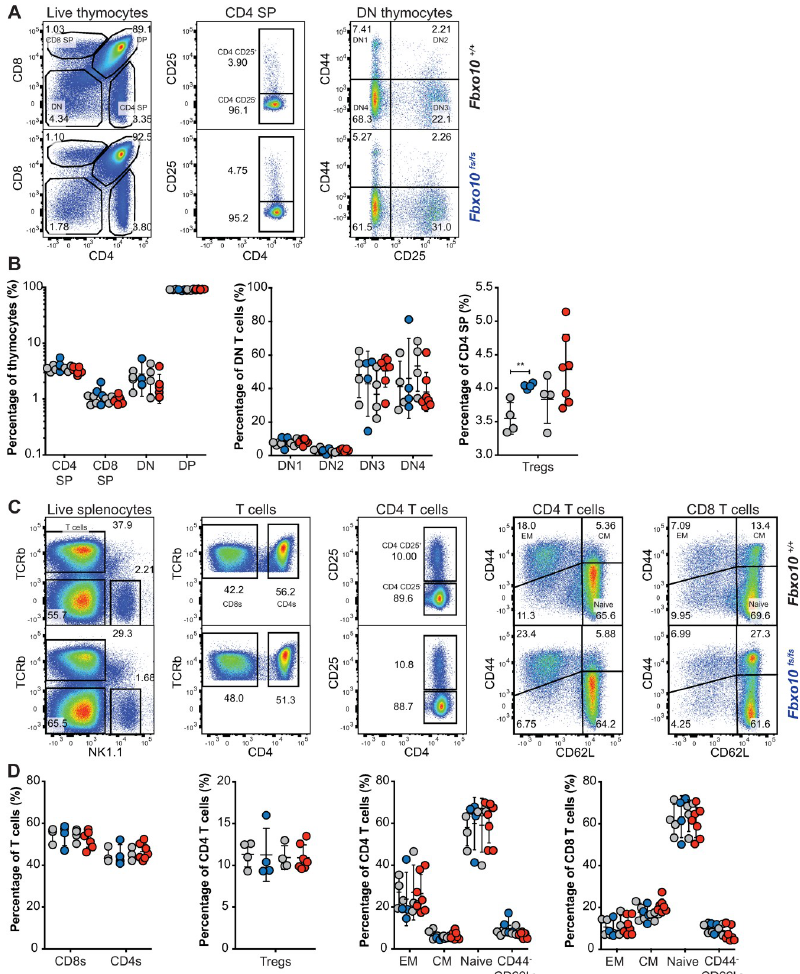
Fig 5. Fbxo10 frameshift or missense mutation do not discernably alter thymic or spleen T cell subsets. (A) Representative flow cytometric gating strategy to delineate T cell developmental populations in the thymus. Numbers denote cells in gate as percentage of parent population. (B) T cell developmental subsets in the thymus of Fbxo10 +/+ , Fbxo10 fs/fs , Fbxo10 E54K/E54K mice. (C) Representative flow cytometric gating strategy to delineate splenic T cell subsets. (D) T cell subsets in the spleen of Fbxo10 +/+ , Fbxo10 fs/fs , Fbxo10 E54K/E54K mice. B, D: each dot represents data from an individual mouse: Fbxo10 +/+ in grey, Fbxo10 fs/fs in blue, Fbxo10 E54K/E54K in red as in Fig 2. Results representative of n = 2 experiments on mice 40–50 weeks old, and similar results observed in n = 2 experiments on mice 10–20 weeks old. Statistical analysis: t-test corrected for multiple comparisons using the Holm-Sidak method, �� p < 0.01, all other differences were not